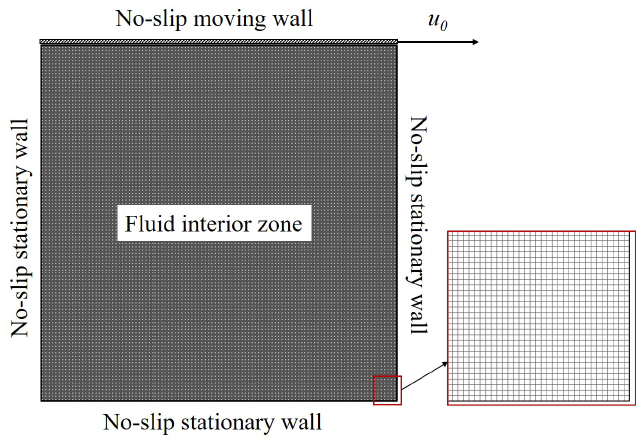
Figure 2. Geometry of the lid-driven cavities.